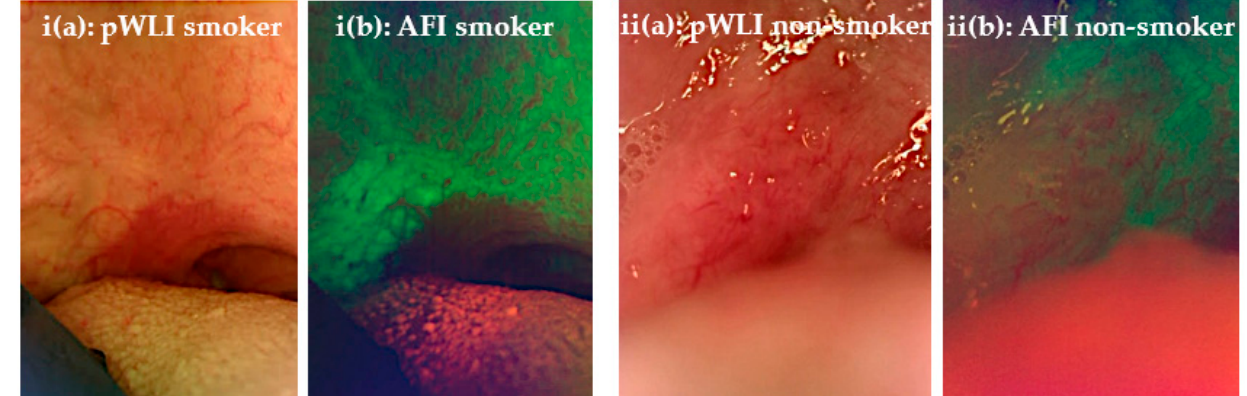
Figure 4. Erythematous anterior tonsillar pillar in ( i ) smoker (left image pair), ( ii ) non-smoker (right image pair). Left side of each image pair ( a ): polarized white light image; Right side of each image pair ( b ): autofluorescence image. In the polarized white light image of smoker’s tissues (left image pair, left side ( i ( a )), note the thick, scaly hyperkeratinized surface layer, which exhibits strong backscattering in the autofluorescence image (left image pair, right side ( i ( b )) vs. the non-smoker’s tissues (right image pair ( ii ( a ) and ii ( b )).